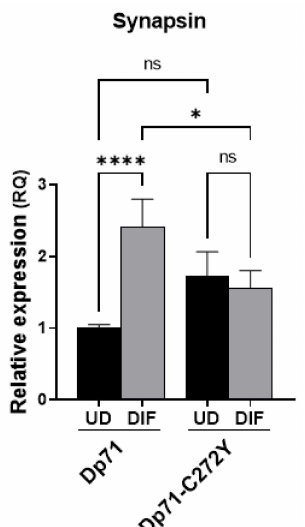
Figure 9. Dp71 but not Dp71-C272Y induces the expression of synapsin in neuronal cells. N1E- 115 cells transiently expressing GFP-Dp71 or Dp71-C272Y were induced to neuronal differentiation by 3 days of DMSO treatment. The expression of synapsin mRNA was analyzed by quantitative reverse transcription polymerase chain reaction (qRT-PCR) in the transfected undifferentiated (UD) and differentiated (DIF) cells. TBP was used as endogenous control. Data correspond to the mean ± SEM of three independent experiments, with significant differences obtained by one-way ANOVA and Sidak’s multiple comparison test (ns, not significant; *, p < 0.05, ****, p <